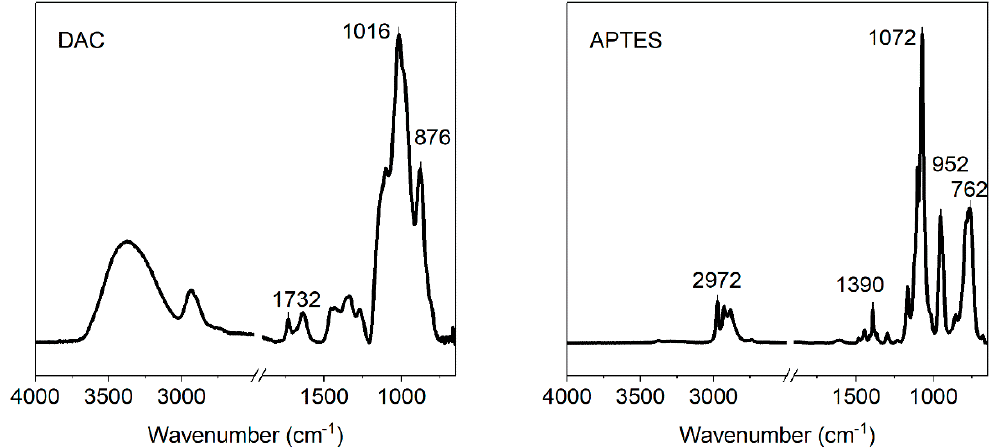
Figure 1. Fourier-transform infrared (FTIR) spectra of dialdehyde cellulose (DAC) (left) and (3-aminopropyl)triethoxysilane (APTES) (right). The labelled bands, from left to right, correspond to: carbonyl stretching (1732 cm − 1 ), C-O stretching (1016 cm − 1 ), and hemiacetal bond stretching (876 cm − 1 ) in the DAC spectrum; C-H methyl group asymmetrical stretching (2972 cm − 1 ), C-H methyl group deformation (1390 cm − 1 ), Si-O stretching (1072 cm − 1 ), skeletal vibration (952 cm − 1 ), and C-H bending (762 cm − 1 ) in the APTES spectrum.